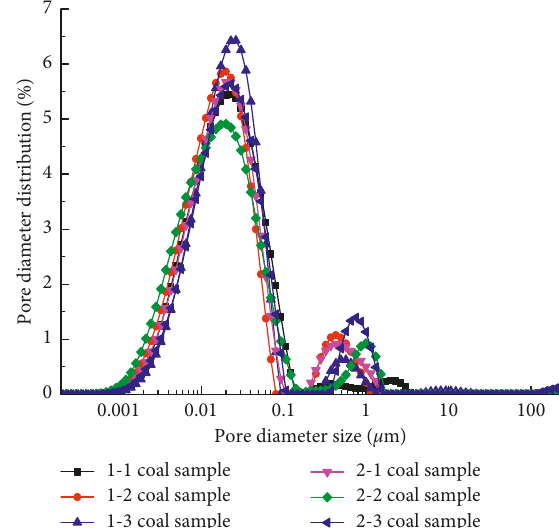
Figure 1: Pore diameter distribution in coal samples.